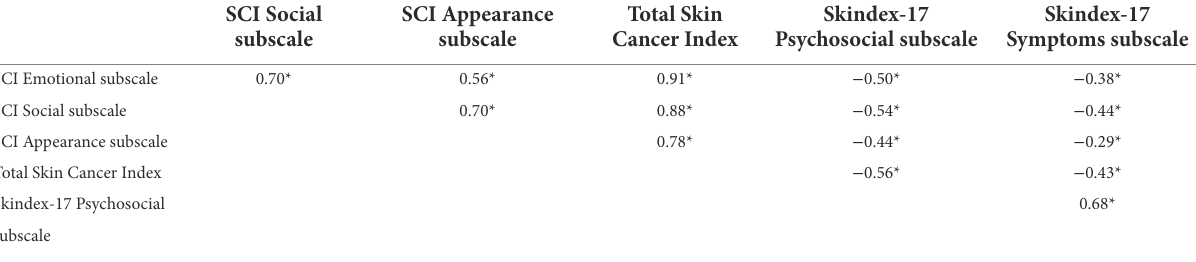
TABLE 4 Spearman correlation between SCI subscales, SCI Total Skin Cancer Index, and Skindex-17 subscales (N